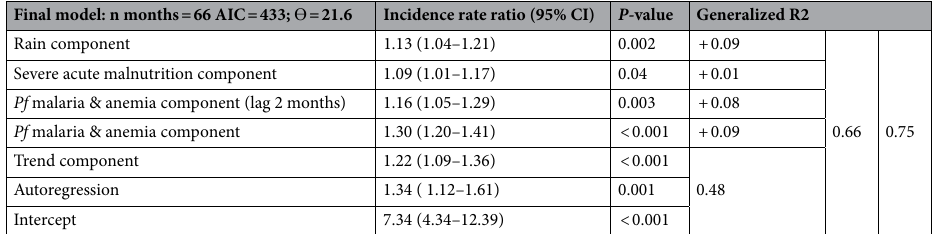
Table 2. A model of environmental and host-associated components explains the seasonal dynamics of non- typhoidal Salmonella (NTS) bloodstream infections in children < 5 years old admitted to Kisantu hospital, DR Congo. AIC: Akaike Information Criterium; Generalized R2: coefficient of determination as specified by Zhang D. that indicates the proportion of variation explained 14 , data shown were rounded to facilitate interpretation; 95% CI, 95% Confidence Interval; Pf, Plasmodium falciparum; Ɵ , dispersion